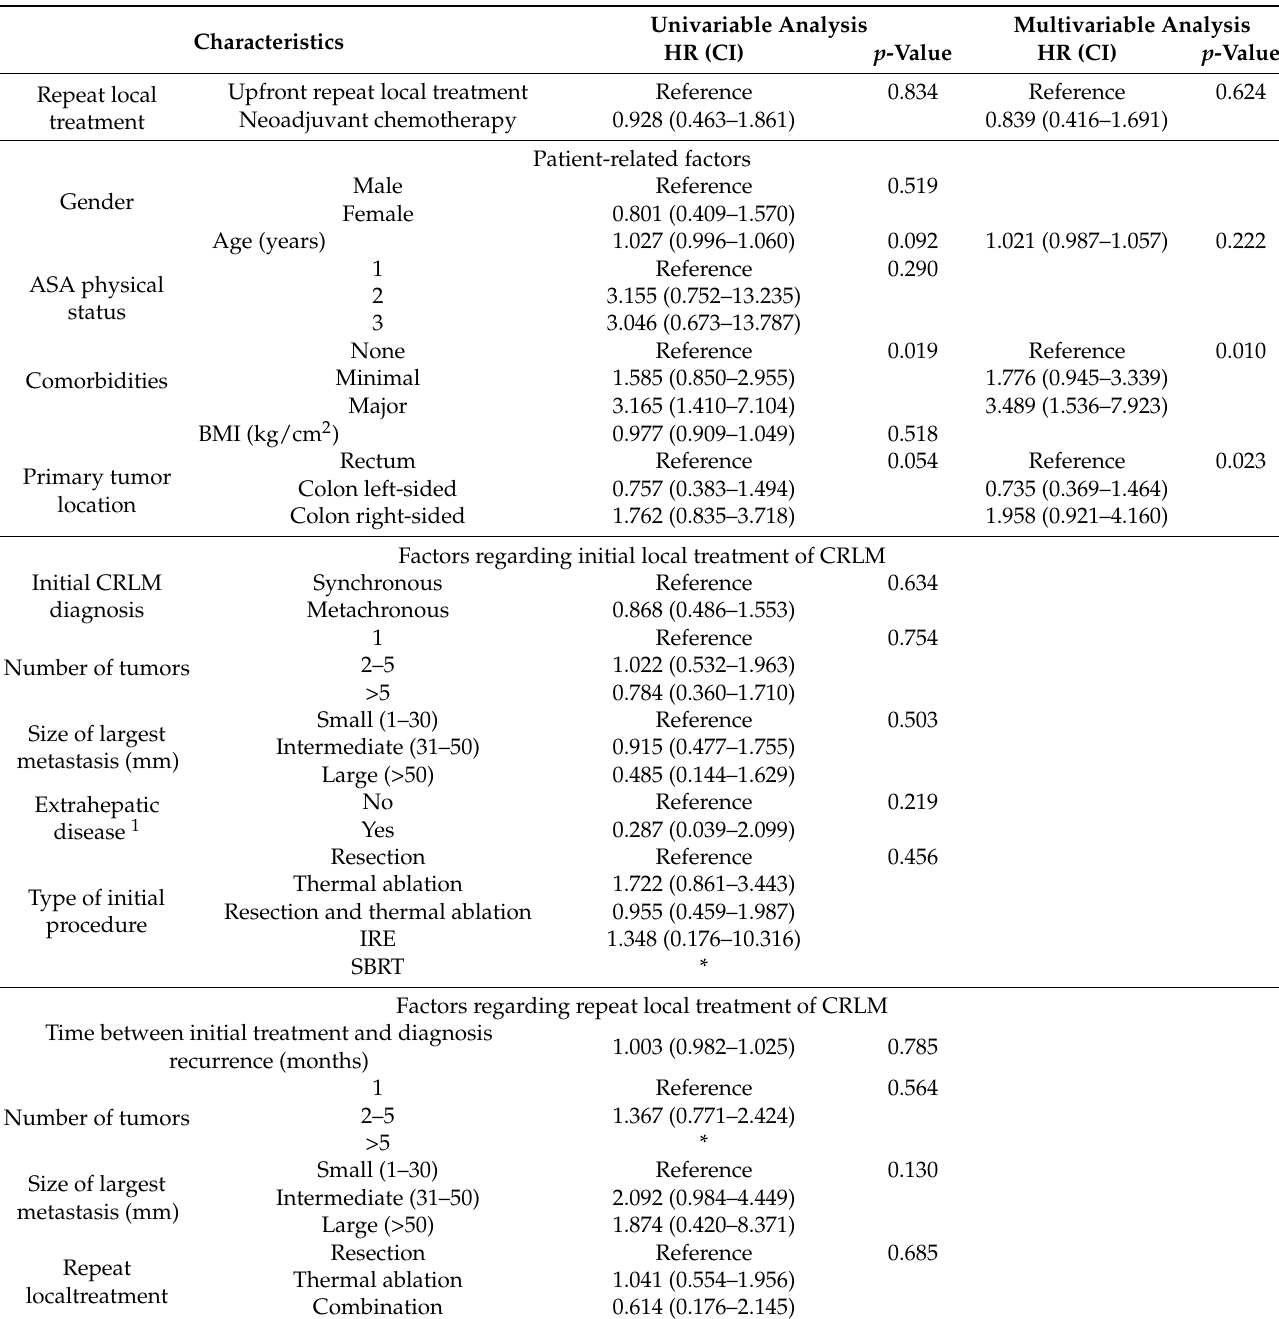
Table 9. Univariable and multivariable Cox regression analysis to detect potential confounders associated with overall survival (OS). After removal of age and adjusting for the confounder comorbidities and primary tumor location, corrected HR of repeat local treatment was 0.839 (95% CI, 0.416–1.691; p =